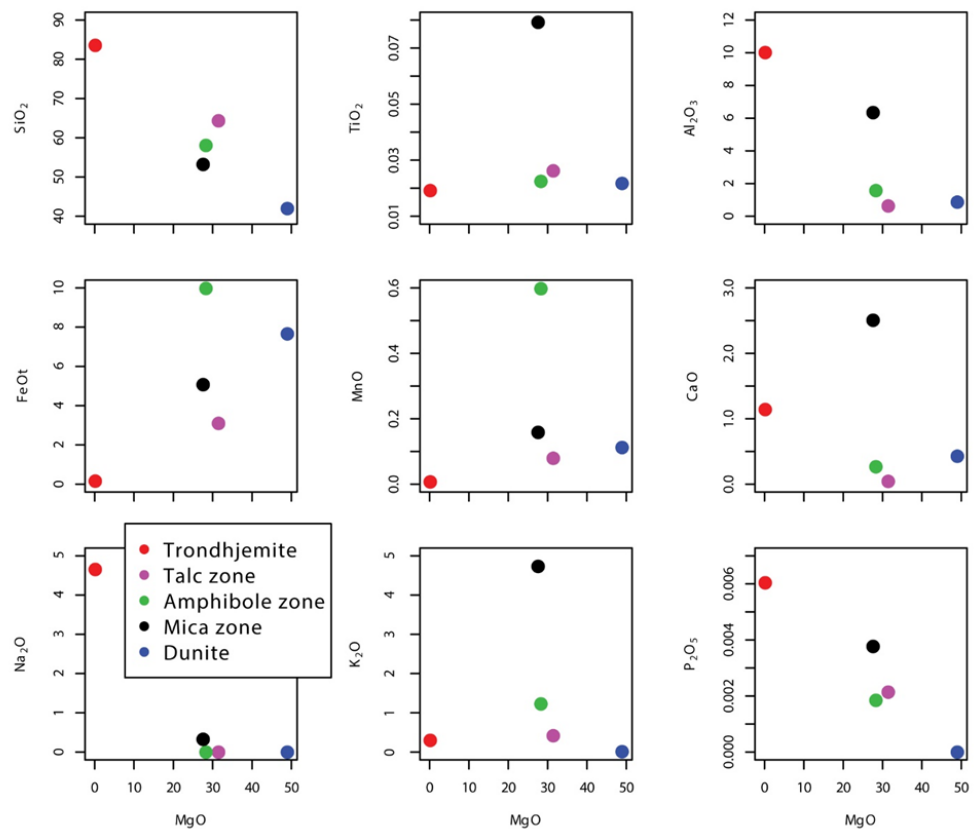
Figure 7. Major elements plotted against MgO contents for the samples of this study. The three metasomatic zones generally plot intermediate between the dunite and trondhjemite, which form compositional endmembers. The mica zone diverges from this trend by having significantly higher K 2 O, CaO, and TiO 2 than the rest of the samples. Please note that the data for the dunite sample are from [5]. All oxides are given in wt.%.